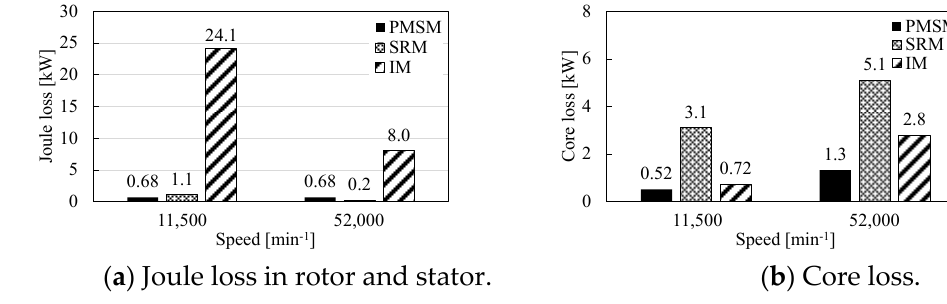
Figure 22. Comparison of joule loss and core loss.